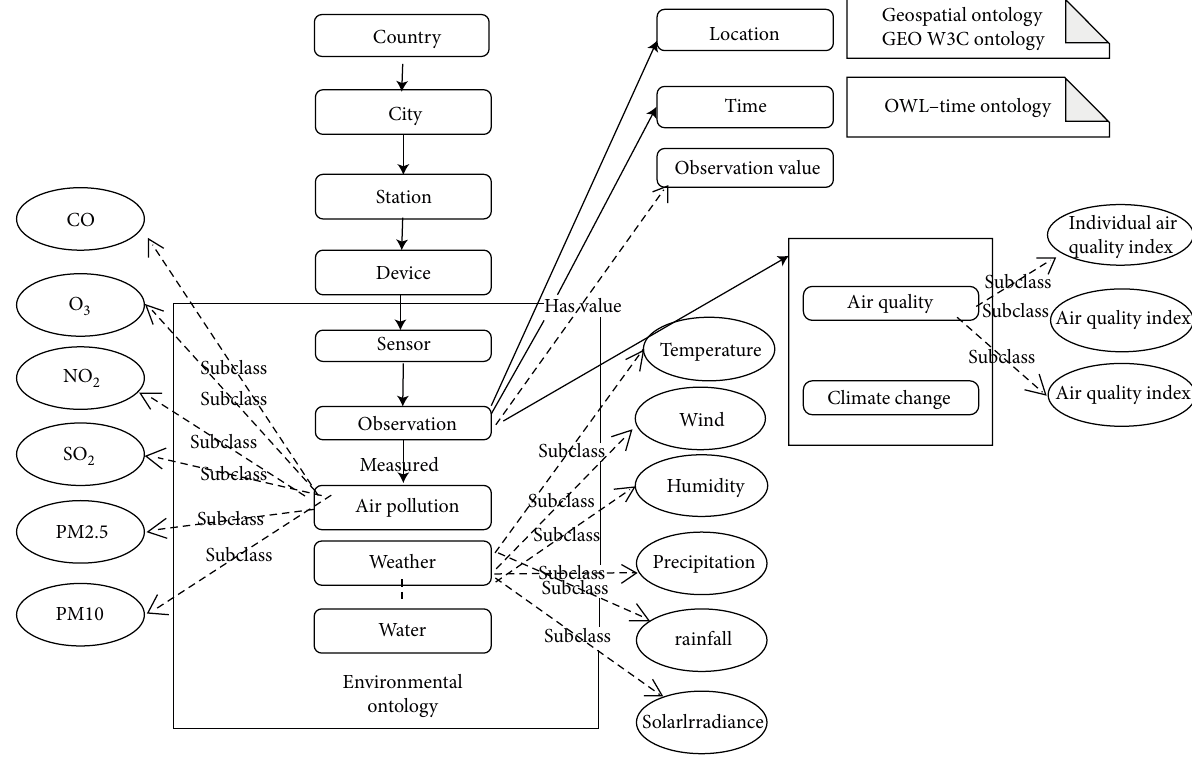
Figure 7: Smart City environmental ontology.